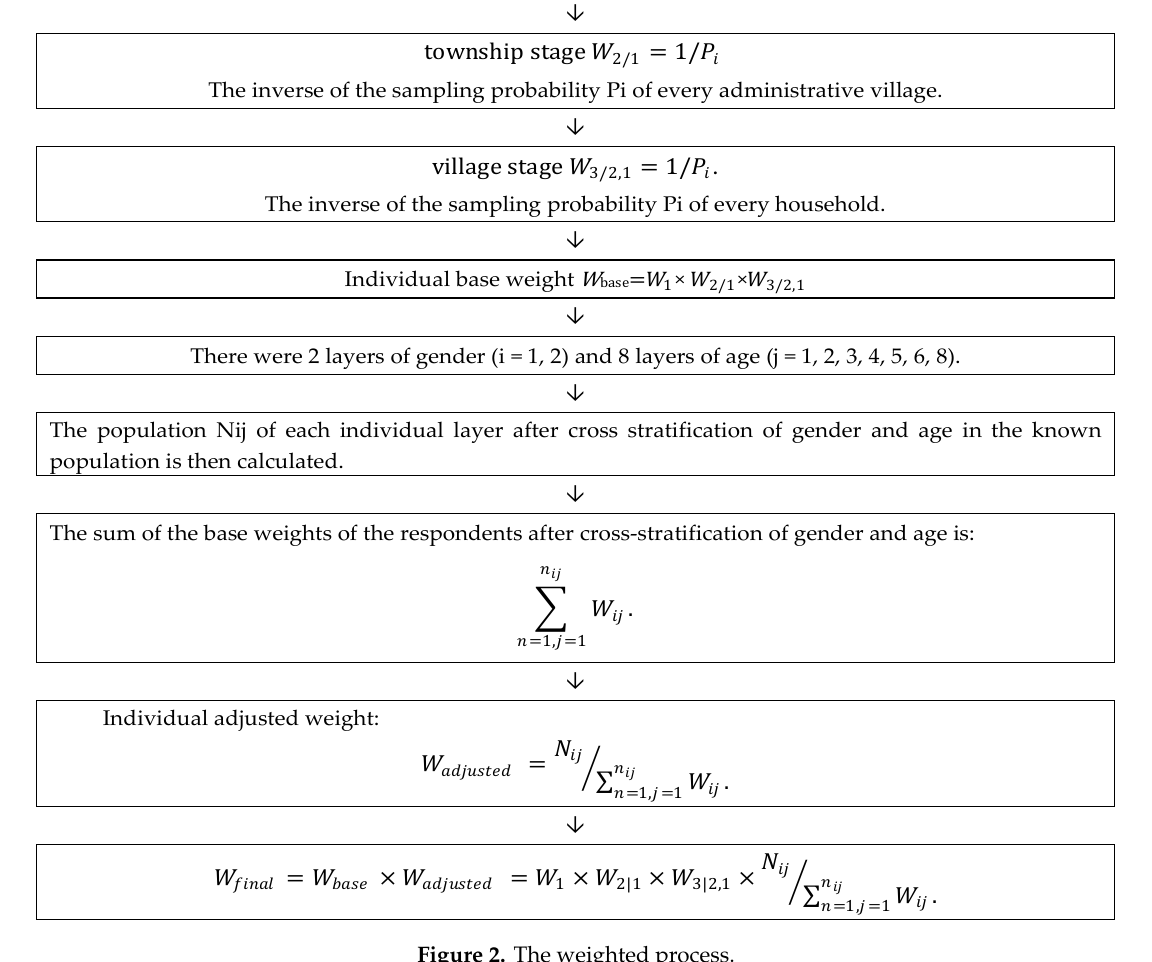
Figure 2. The weighted process.